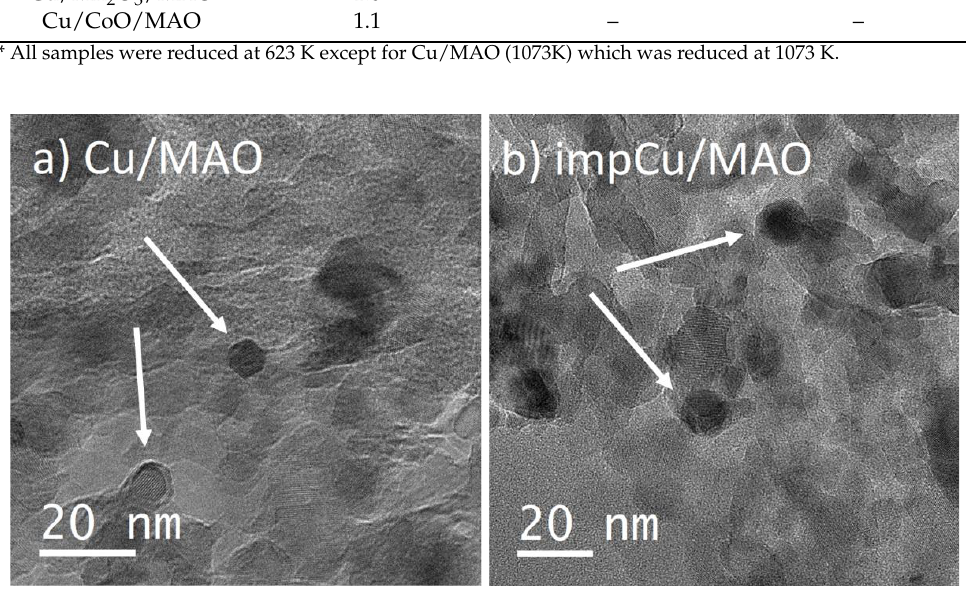
Figure 4. TEM images of ( a ) Cu/MAO and ( b ) impCu/MAO. Cu particles are shown by the arrows.